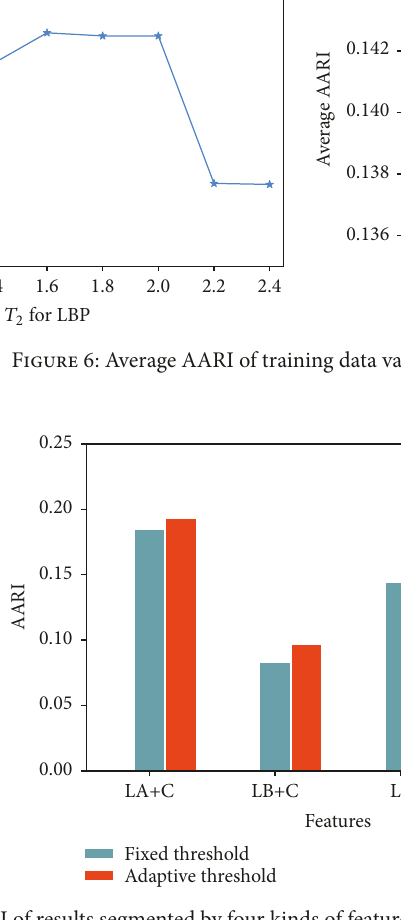
Figure 7: Average AARI of results segmented by four kinds of features with fixed threshold and adaptive threshold.